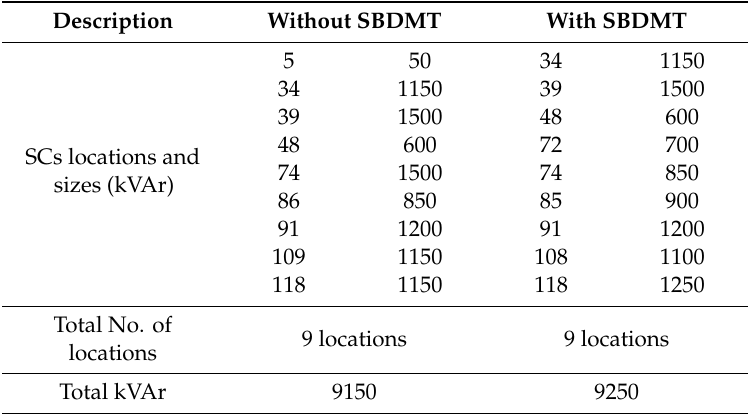
Table 14. Comparison between the optimal locations and sizes of SCs by PODESCA for the 118-bus system with and without reducing the search space by SBDMT.